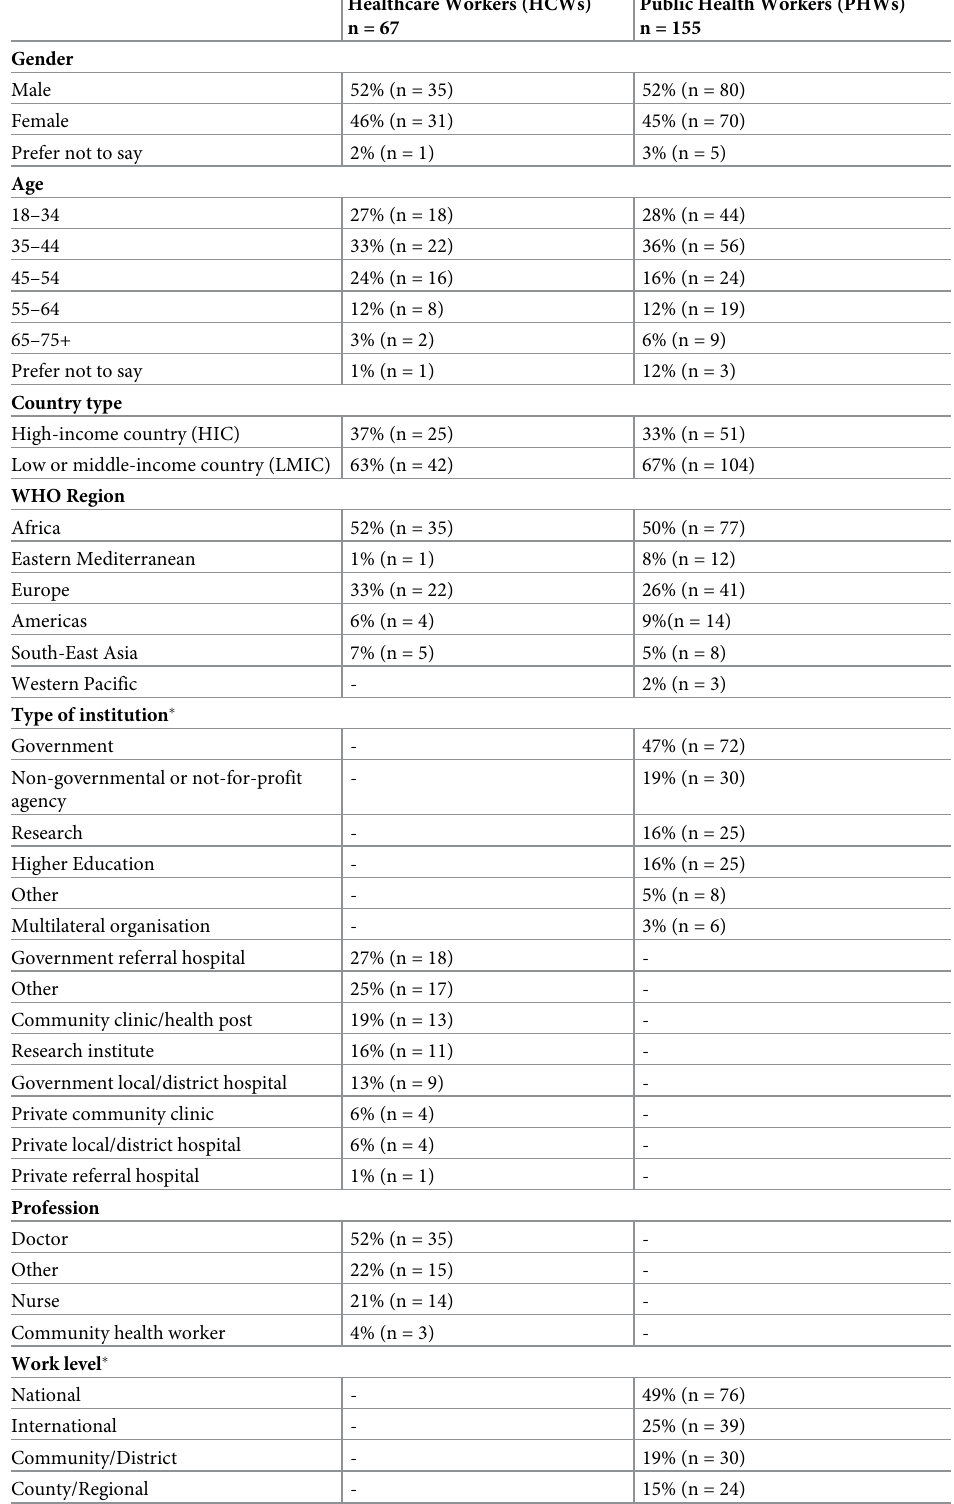
Table 2. Respondents’